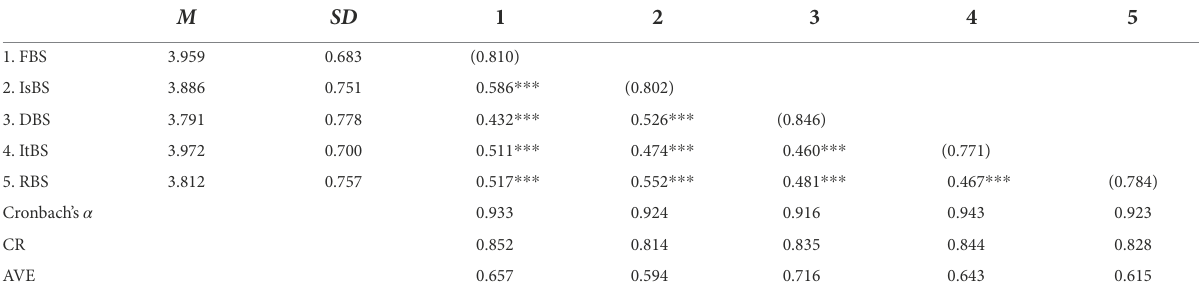
TABLE 4 Means, standard deviations, scale reliabilities, correlations, CR, and AVE for